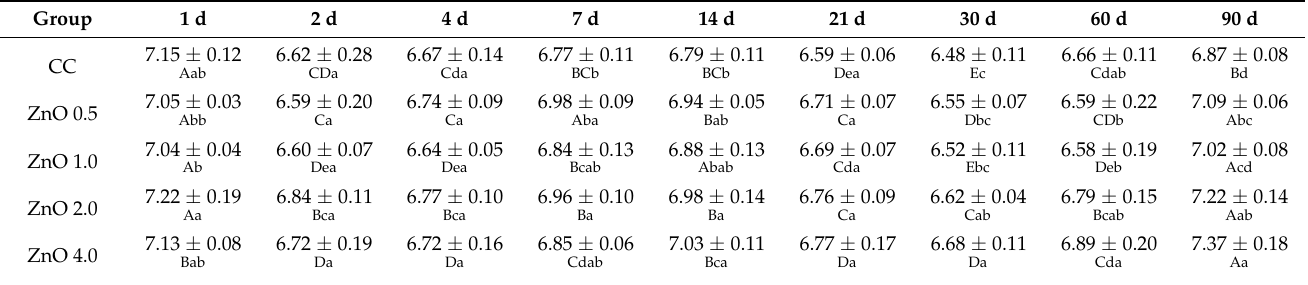
Table 2. The pH change for 90 days (means ± SD). The uppercase letters mean comparison by time within the same group.